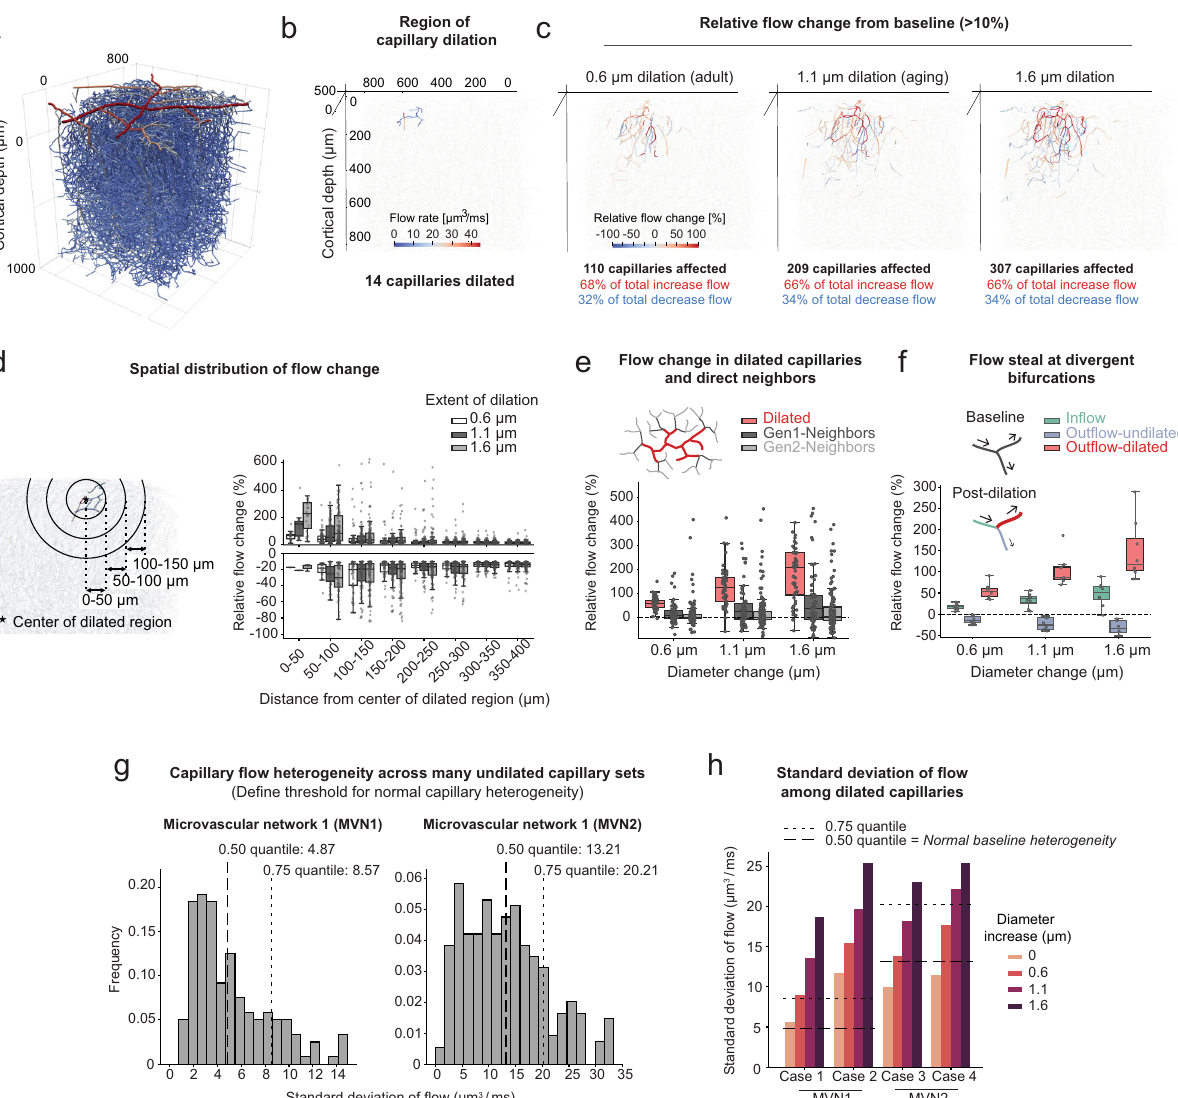
Fig. 8 | Impact of local capillary dilations examined in silico. a Microvascular network 1 (MVN1) from mouse parietal cortex. b Example of a typical region affected by pericyte ablation in MVN1. The color bar shows the fl ow rates in individual capillaries pre-ablation. c Relative fl ow changes >10% of baseline in the entire MVN1 for an increasing extent of dilation. Vessels with a relative fl ow change between − 10% and +10% are not colored and depicted by the light gray lines. d Relative fl owchange>10%ofbaselineatdifferentdistancestothecenter ofthedilatedcapillaries. n (0.6) = 808vessels, n (1.1) = 1114vessels, n (1.6)=1367 vessels. e Relative fl ow changes in the dilated vessels and their direct neighbors (Gen1-Neighbors and Gen2-Neighbors, see schematic). n (0.6, 1.1, 1.6) = 267 vessels each. f Flow steal at divergent bifurcations with one dilated out fl ow